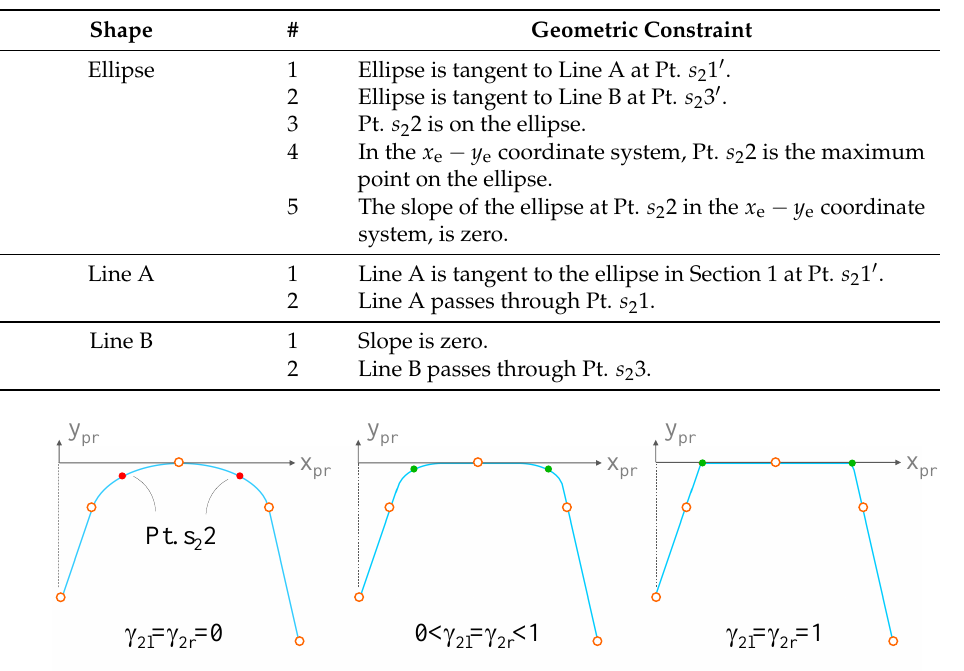
Table 6. Constraints on Line A, Line B, and the ellipse.